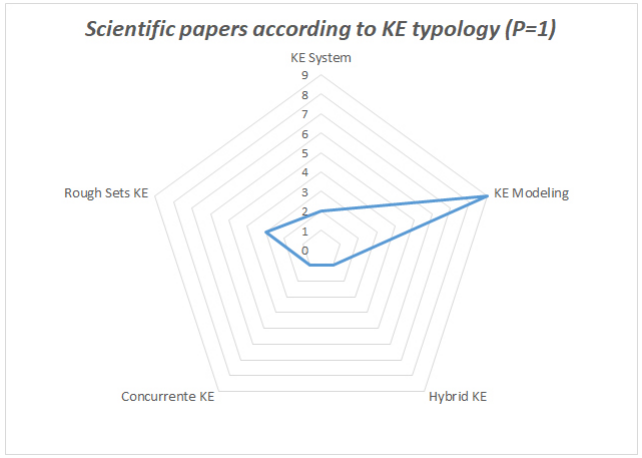
Figure 6. Incidence of KE typology on articles that obtained a score of P = 1. Table 7. Incidence of KE typology on articles that obtained a score of P = 0.75 to P = 1.00. TYPE OF KE (P = 75–100)